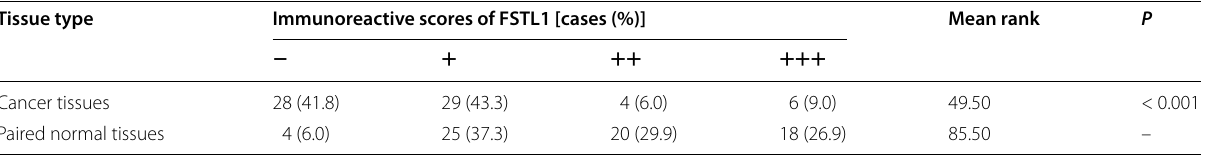
FSTL1 follistatin-like protein 1